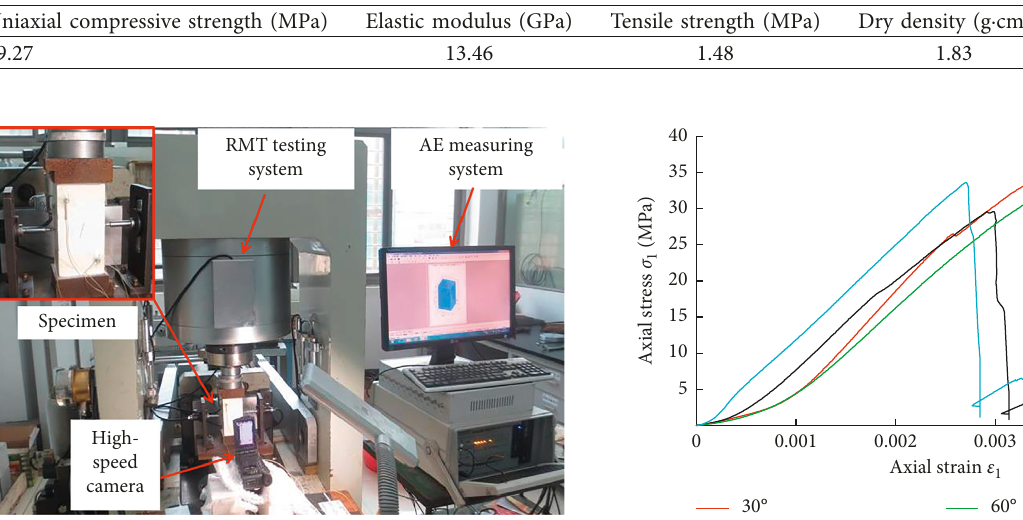
Figure 2: Test loading, acoustic emission monitoring, and camera system. Figure 3: Axial stress-strain curves of specimens containing a single flaw under uniaxial compression.